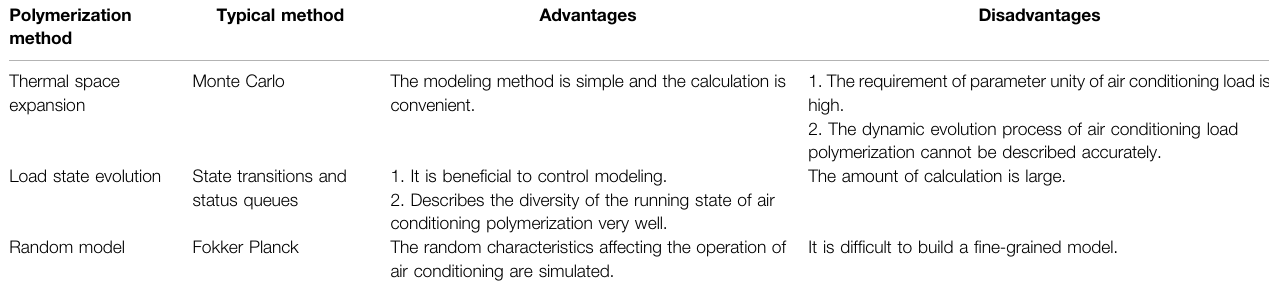
TABLE 3 | Advantages and disadvantages of various aggregation